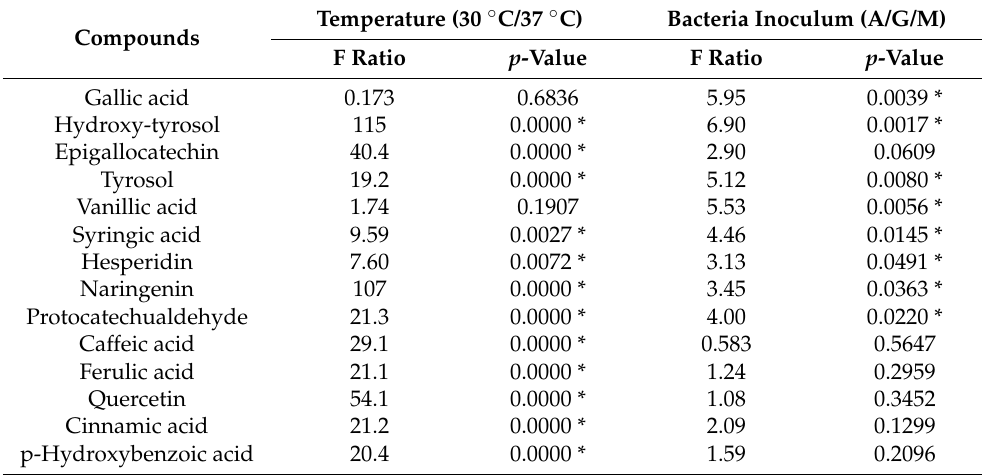
Figure 5. Cluster analysis taking into consideration the composition of polyphenolic compounds of the three prickly pear matrixes. J: prickly pear juice; W: prickly pear wine; A/G/M: prickly pear vinegar. Table 5. Analysis of variance considering the effect of temperature (30 ◦ C/37 ◦ C) and bacteria inoculum ( Acetobacter (A) /Gluconobacter (G)/Mixture of bacteria (M)) on phenolic compounds of prickly pear vinegar produced by surface